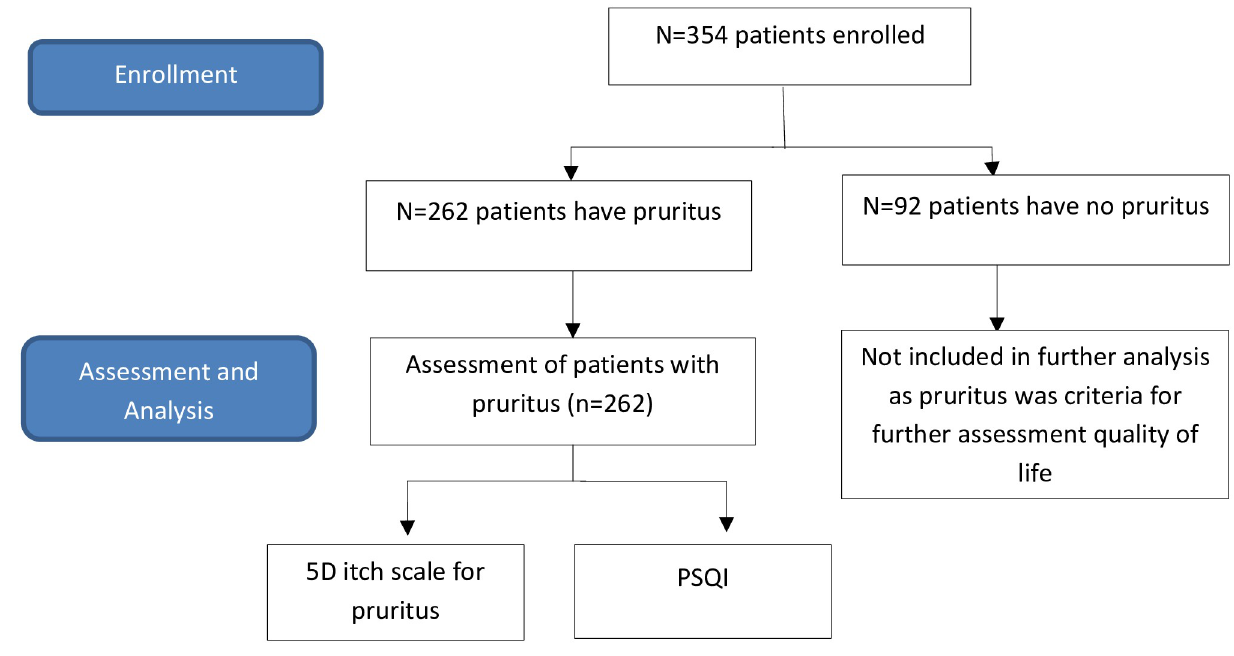
Fig 1. Study flow